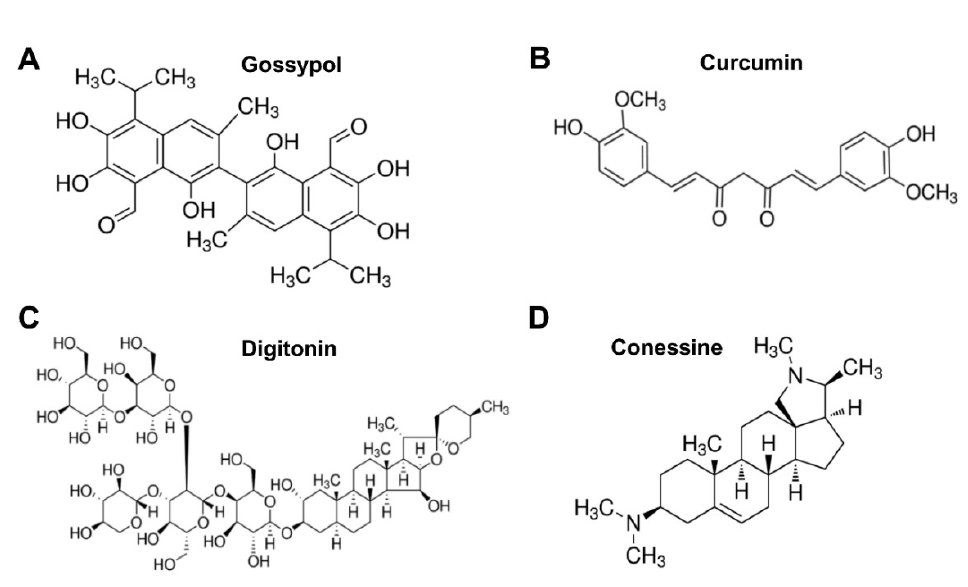
Table 1. Initial screening of a natural product library for identification of potential anti-ZIKV inhibitors. Parameters No. (%) Natural products from MicroSource Discovery Systems for screening 720 Primary hits (with inhibition against ZIKV strain PAN2016) a 61 (8.5) Primary hits (with high cytotoxicity in Vero E6 cells) b 38 (5.3) Specific hits (primary hits with low cytotoxicity) 23 (3.2) Specific hits (ordered from Sigma and retested to confirm anti-ZIKV activity) Specific hits (available to purchase) 16 (2.2) 6 (0.8) Specific hits displaying IC 50 < CC 50 4 (0.6)